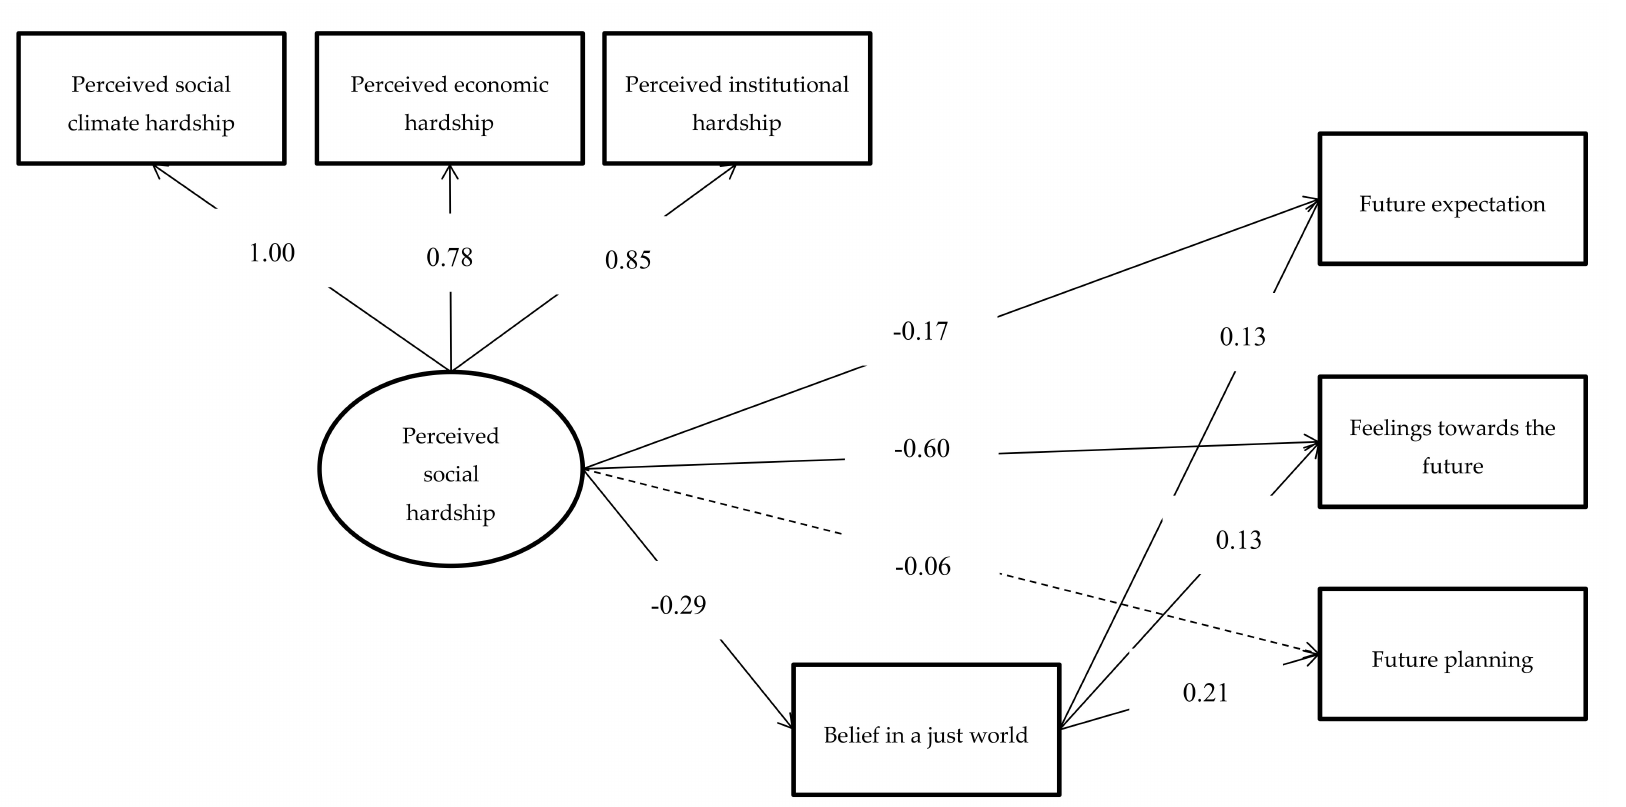
Figure 2. Mediation model of belief in a just world in the association between perceived social hardship and future orientation. Note: the associations between demographic variables and perceived social hardship, belief in a just world, and the three future orientation components were controlled for and presented in Table 2, but they are not shown in the figure for simplicity. Solid line indicates significant paths; dash line indicates insignificant